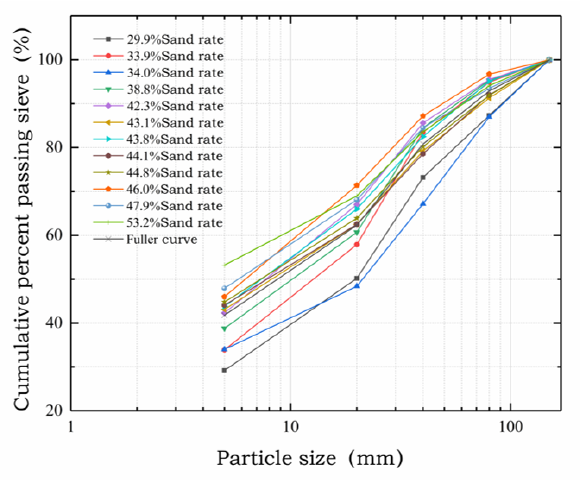
Figure 1: 12 Gravel Gradation and Fuller